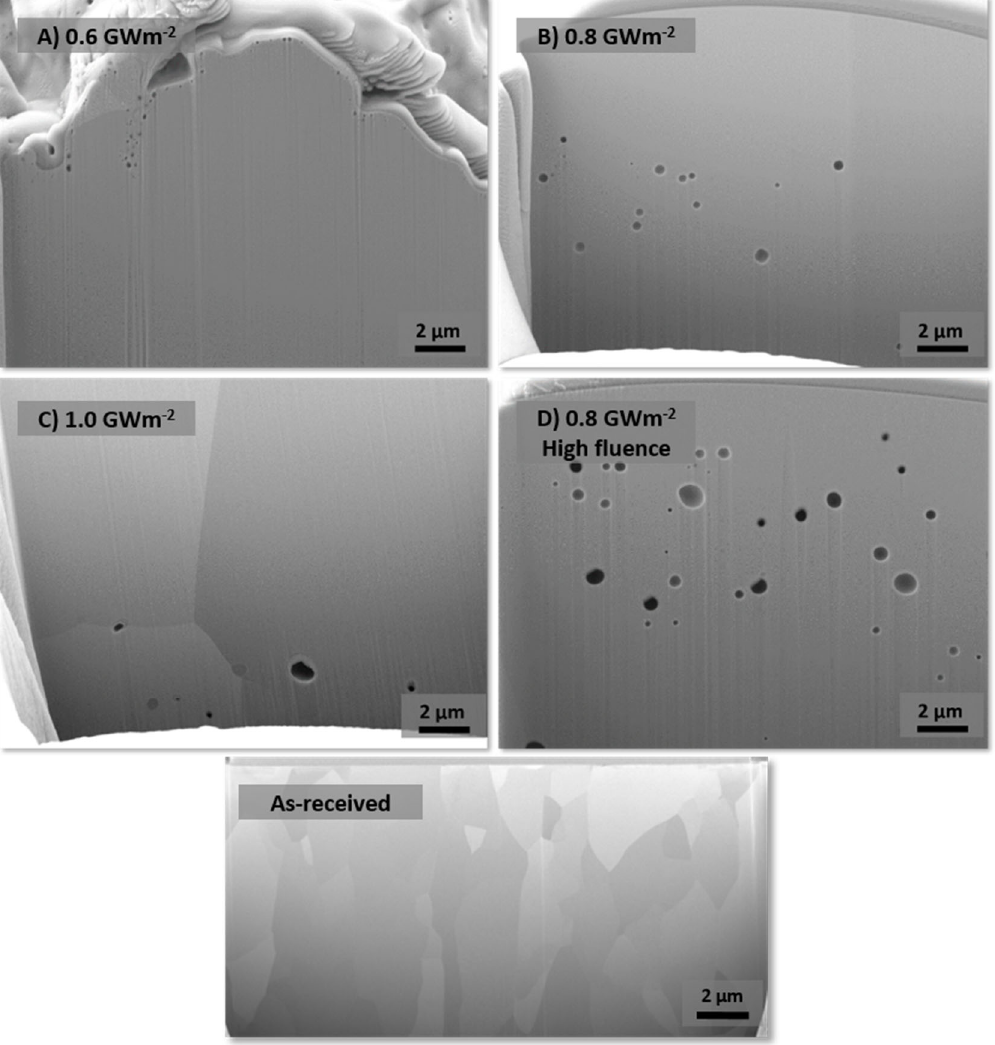
Figure 3. FIB cuts of the laser ‐ affected area of all samples exposed to D/He(6%) plasma. Samples were simultaneously exposed to 10 5 laser pulses with a P abs of ( A ) 0.6 GWm − 2 , ( B ) 0.8 GWm − 2 , ( C ) 1.0 GWm − 2 , ( D ) 0.8 GWm − 2 and of an as ‐ received sample. Sample D was exposed to a higher plasma fluence than samples A, B and C.